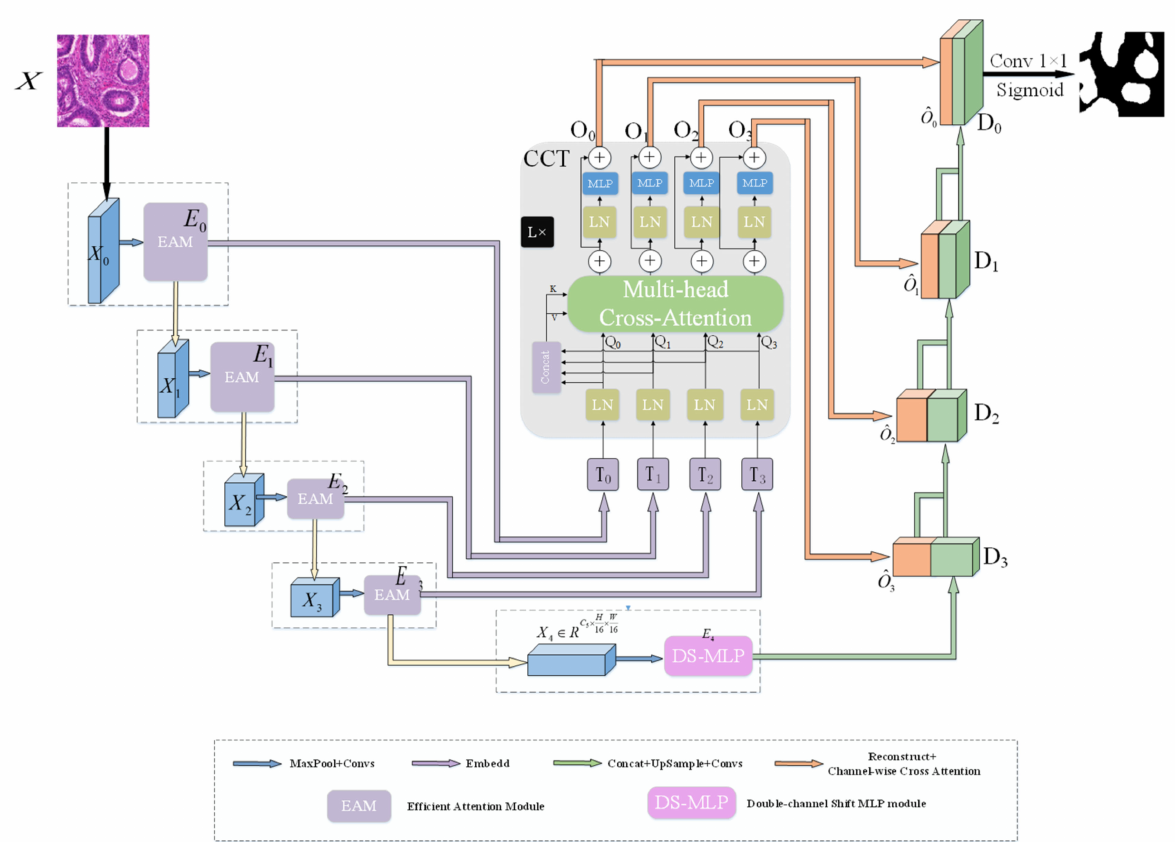
Figure 1. The architecture diagram of